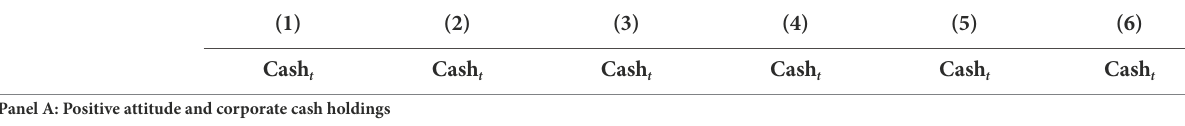
TABLE 11 Six major topics of COVID-19 and corporate cash holdings (future outlook